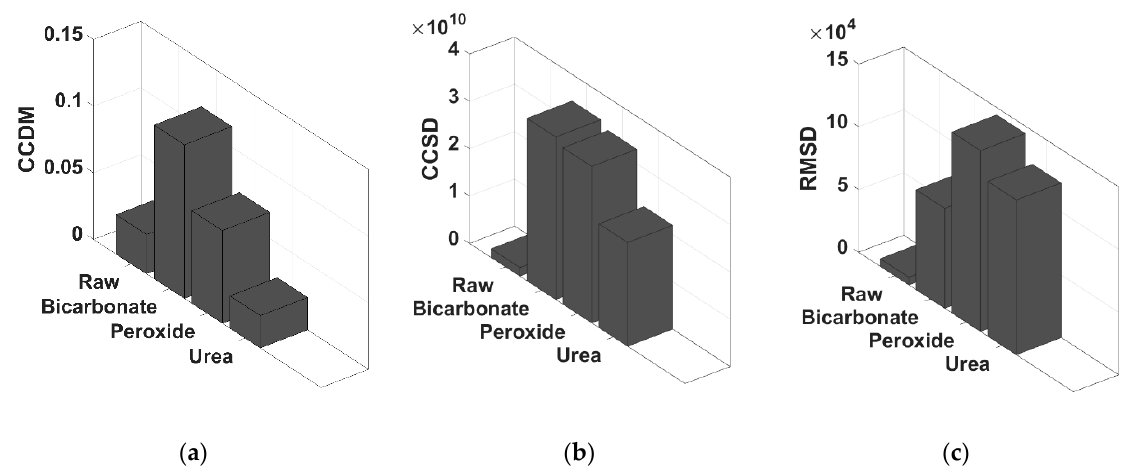
Figure 5. Statistical Indexes for contaminated and non-contaminated milk: ( a ) CCDM, ( b ) CCSD and ( c ) RMSD.